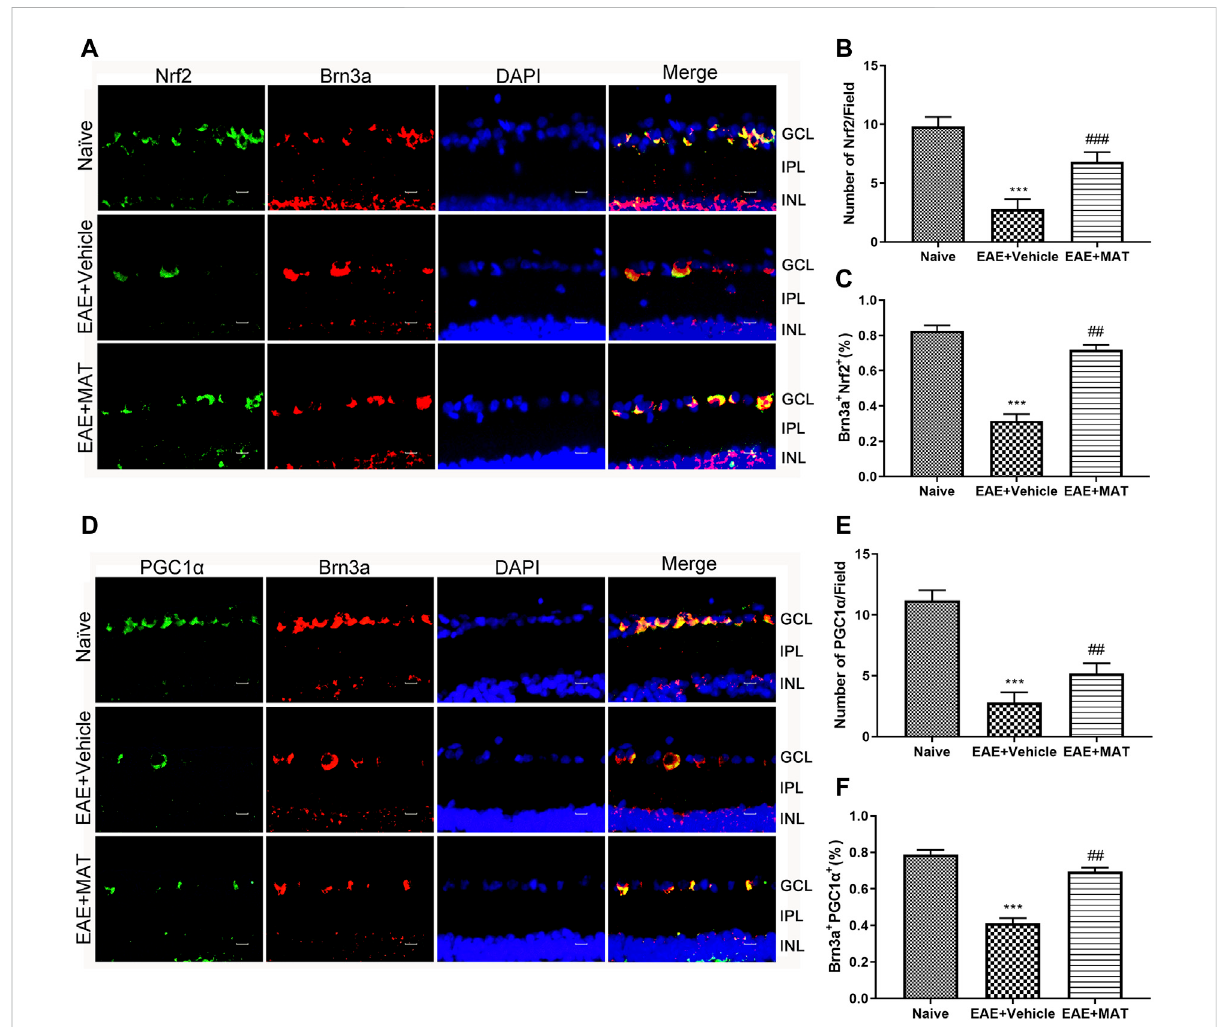
MAT elevated the expression of Nrf2 and PGC-1 α . Eyeballs were harvested from naive rats, MAT- and vehicle-treated rats. (A) Immuno fl uorescence double staining suggested that Nrf2 (FITC, green) were colocalized with Brn3a (Cy3, red) (200×). Scale bars, 10 μ m. (B) Quantitative analysis of the number of positive cells. (C) Quantitative analysis of the rate of positive cells. (D) Immuno fl uorescence double staining suggested that PGC-1 α (FITC, green) were colocalized with Brn3a (Cy3, red) in the eyeball retina (200×). Scale bars, 10 μ m. (E) Quantitative analysisofthenumberofpositivecells. (F) Quantitativeanalysisoftherateofpositivecells.Symbolsrepresentmean±SD;n=10ratspergroup.** p < 0.01, *** p < 0.001, comparison betweennaive and vehicle-treated groups.## p < 0.01,comparison between vehicle-and MAT-treated